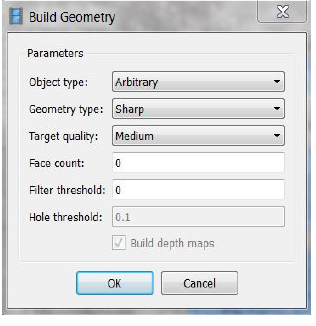
Figure 12 The parameters set for the creation of the mesh.